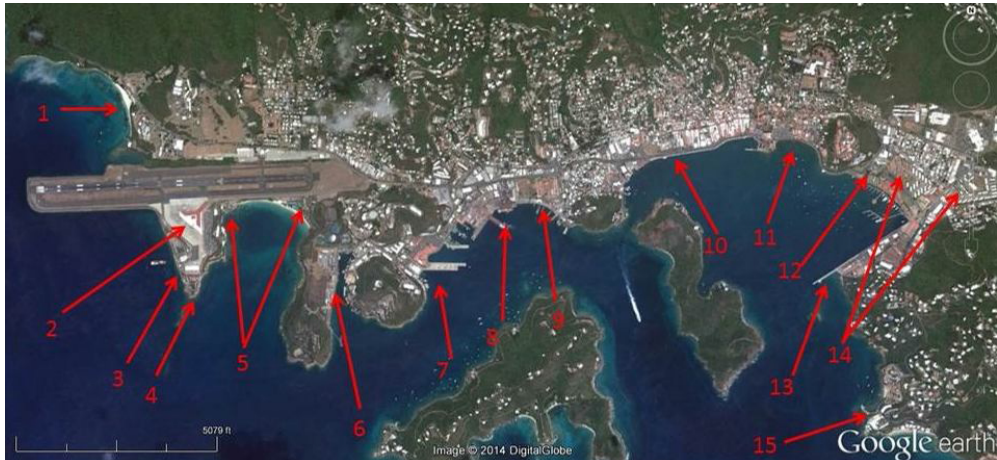
Fig. 4. At-risk sites in and near Charlotte Amalie, St. Thomas, USVI. (1) Shoreline university buildings, (2) airport, (3) airplane fuel stor- age, (4) sewage treatment plant, (5) three shoreline hotels, (6) electricity and desalination plants with storage tanks, (7) 3-berth dock that accommodates the world’s largest cruise ships, (8) marina and container port, (9) school for > 900 students, (10) downtown shopping and historic district, (11) courts, police station and jail, (12) 85-unit senior citizens home, (13) cruise ship dock and upscale marina, (14) two public housing projects with 417 dwellings and (15)